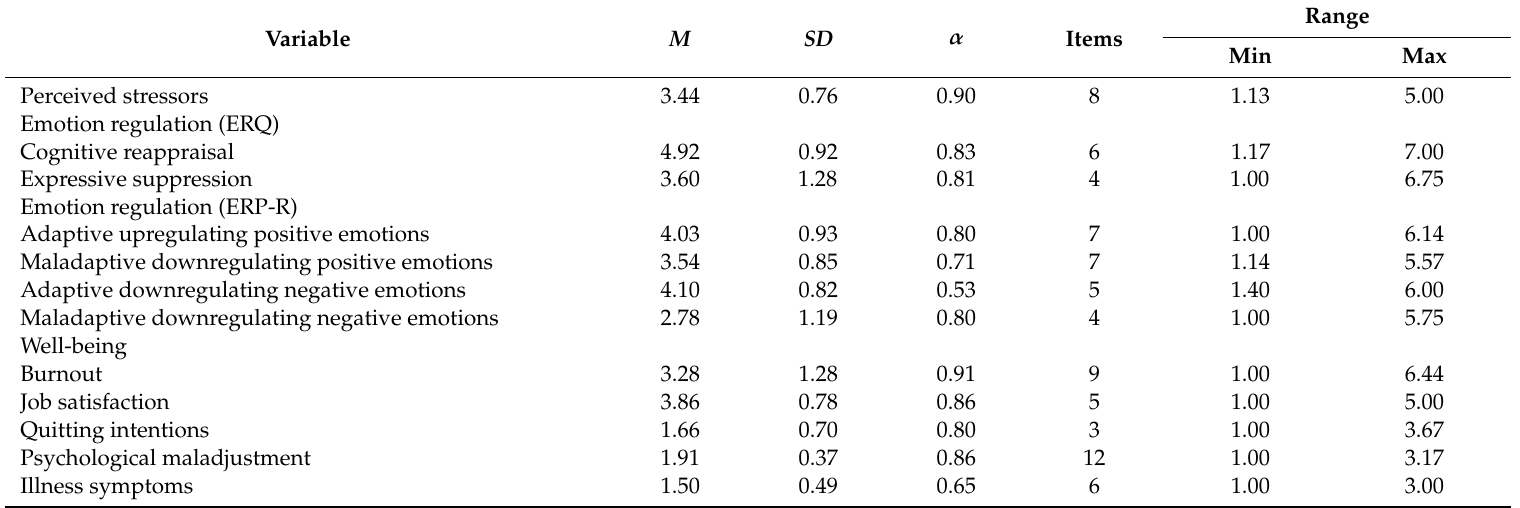
Table 1. Psychometric Properties of Study